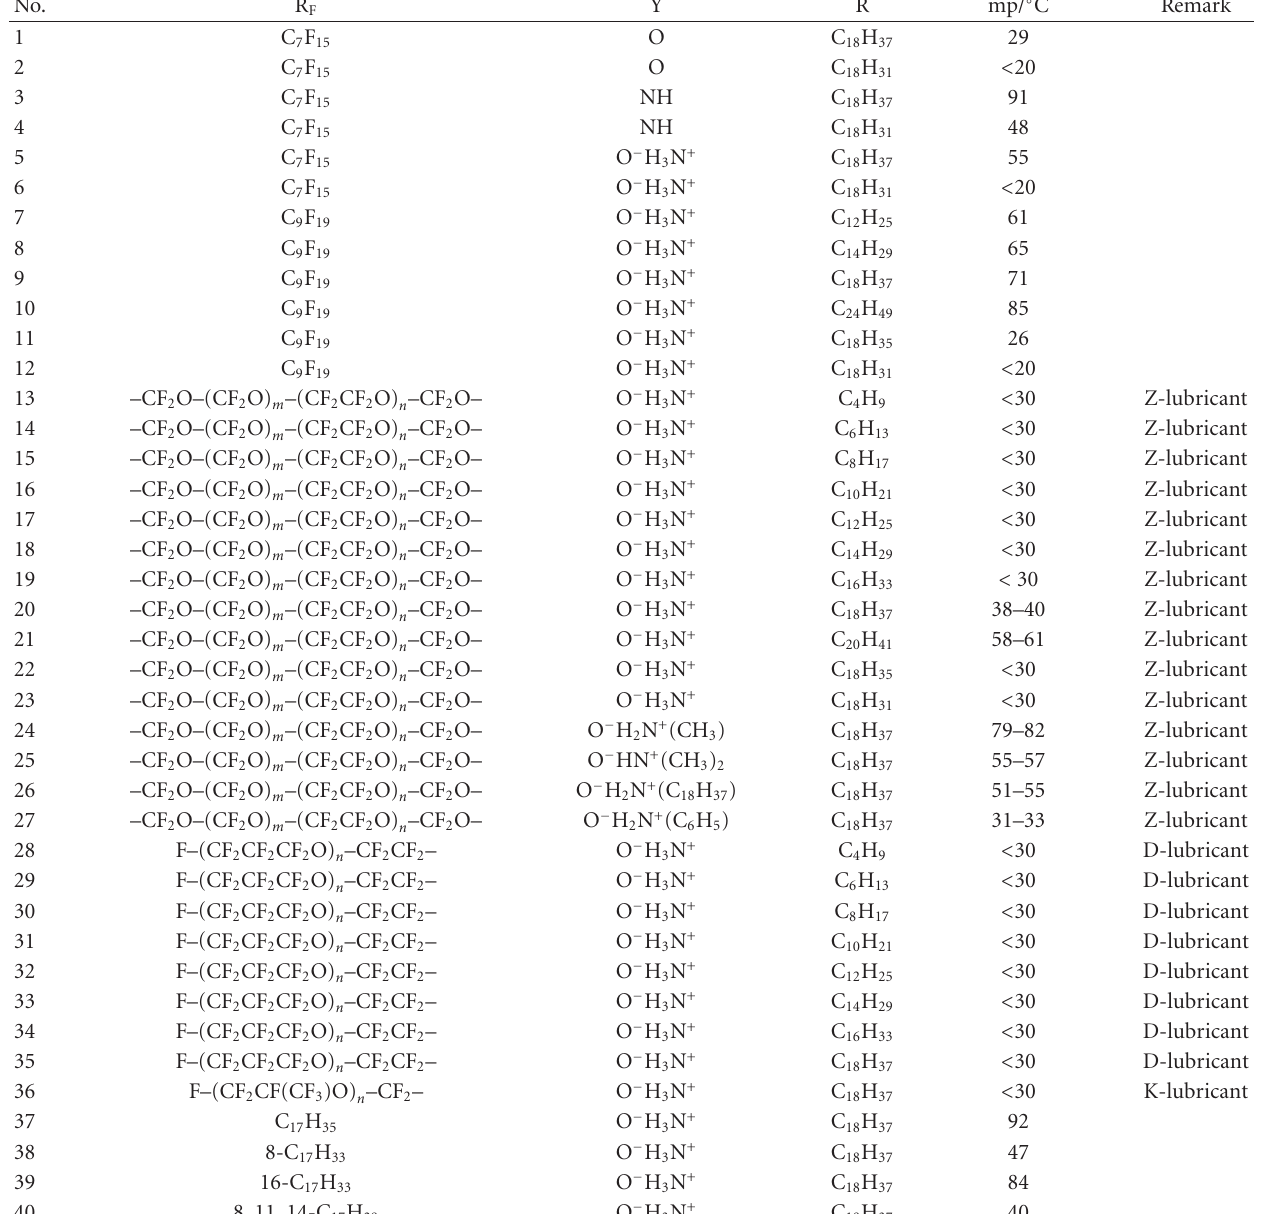
Table 2: Molecular structures and melting points of ionic liquid lubricants R F –CO–Y–R. No.